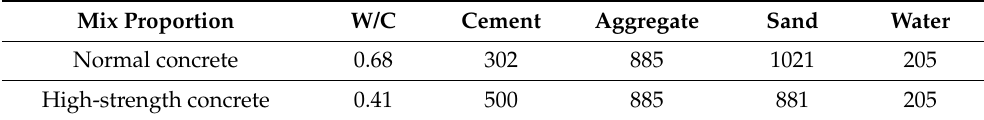
Table 2. Mix proportion for two concretes (kg/m 3